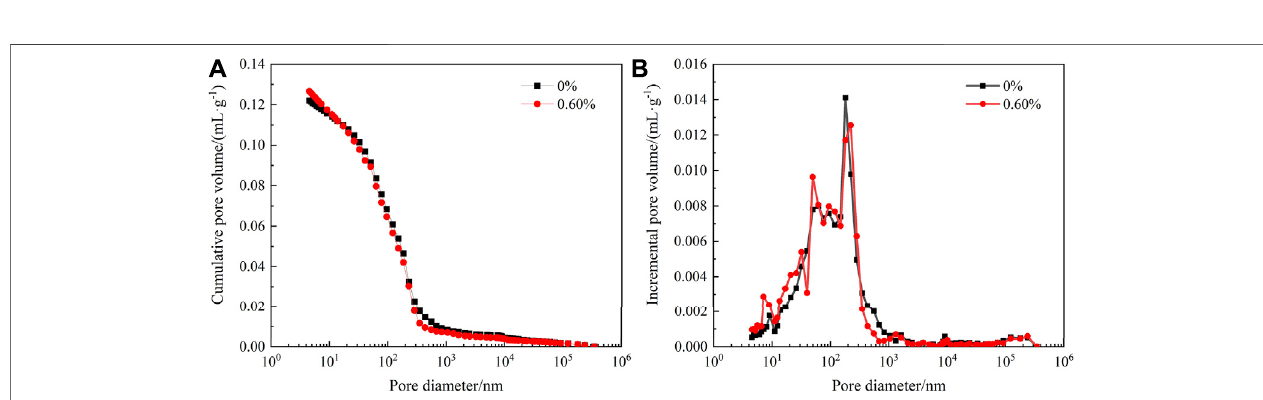
FIGURE 10 | Pore characteristics of high-alumina cement paste with different fi ber content. (A) Cumulative pore volume distribution (B) Pore size distribution.